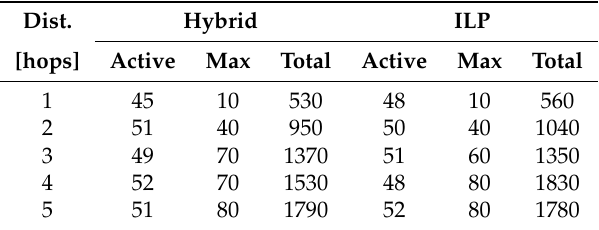
Table 2. Number of active links, wavelengths over the most used link, and total wavelengths for the hybrid and ILP for different distance constraints in network N 38 .